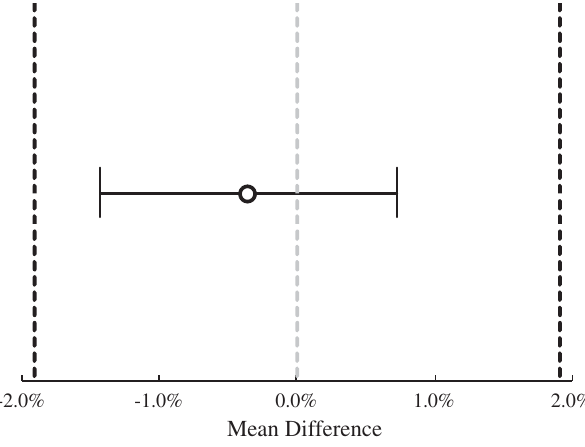
FIG. 8. Mean difference of estimated scores (shown as the circle) and 95% confidence intervals (horizontal line). The Cohen ’ s d z equivalence boundaries are Δ L ¼ − 0 . 11 and Δ U ¼ 0 . 11 . Corre- sponding score equivalence boundaries are Δ L ¼ − 1 . 91 % and Δ ¼ 1 . 91 % (vertical U